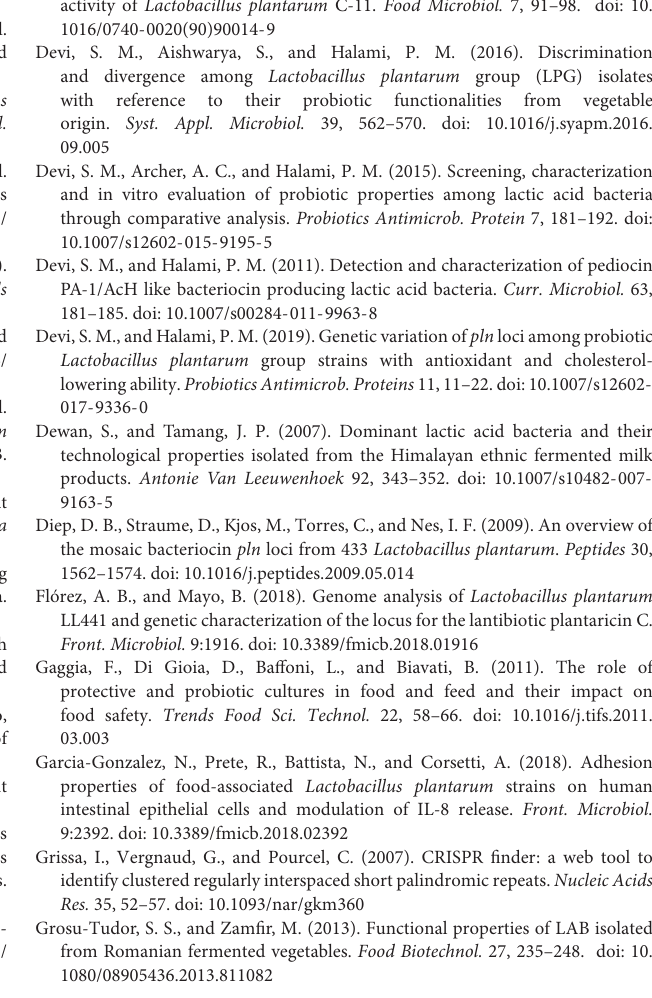
FIGURE S1 | Antimicrobial activity under various environmental conditions. (a) AMA at pH 1, (b) AMA at pH 9, (c) AMA at 121 ◦ C, and (d) AMA of PK treated CFS. TABLE S1 | AMA under various environmental conditions. TABLE S2 | (a) Antioxidant activity (DPPH Assay), (b) Autoaggregation, and (c)